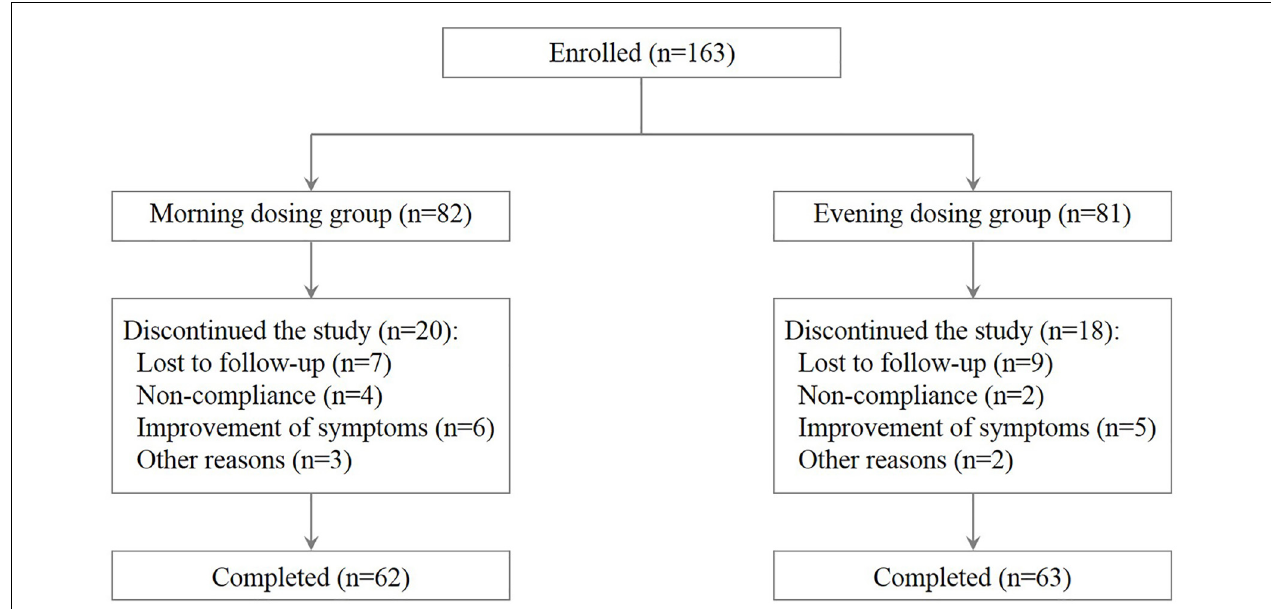
FIGURE 1 | Flow diagram of participant